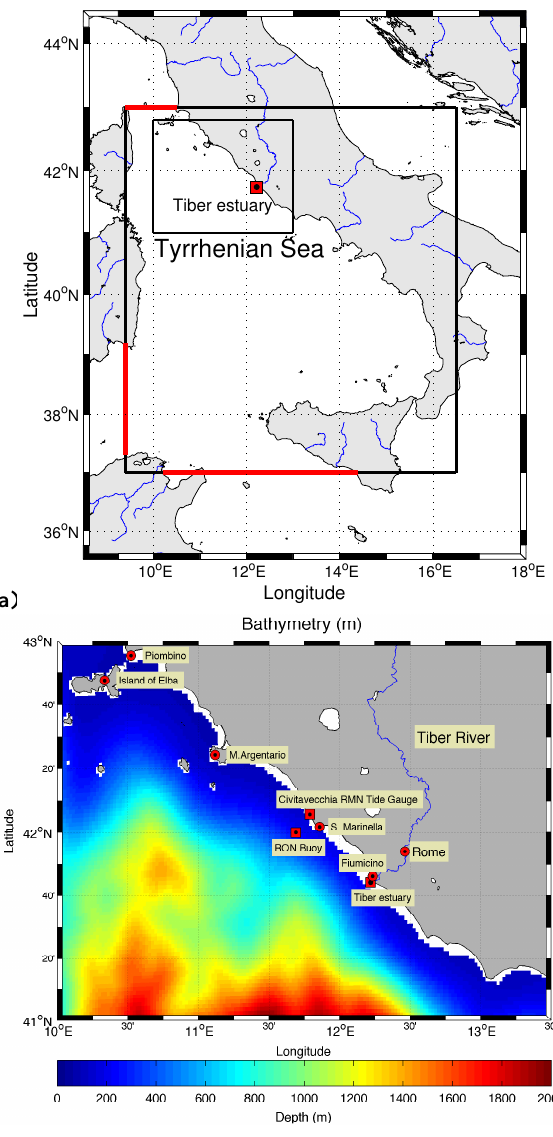
Fig. 1. (a) Outer black box: domain of the numerical simulation (open boundaries are in red). Small internal box is expanded in (b) . (b) Map of the bathymetry north of the Tiber Estuary. The positions of the meteorological onshore and offshore stations are marked with a red